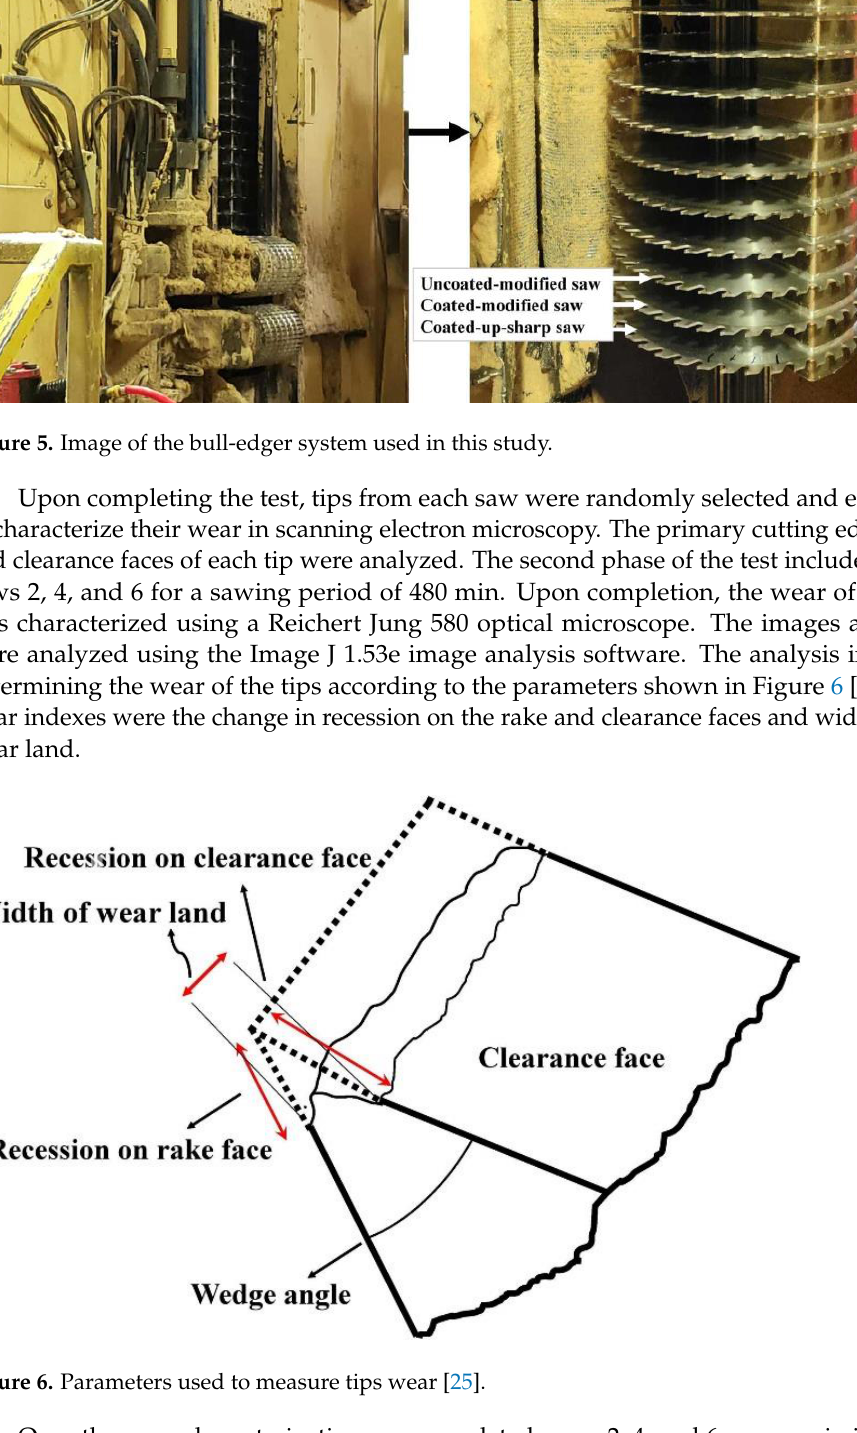
Figure 6. Parameters used to measure tips wear [25]. Once the wear characterization was completed, saws 2, 4, and 6 were again installed in the bull-edger system for the third phase of the study. They were used during another work shift of 480 min. The wear of the tips was then analyzed in optical and scanning electron microscope.